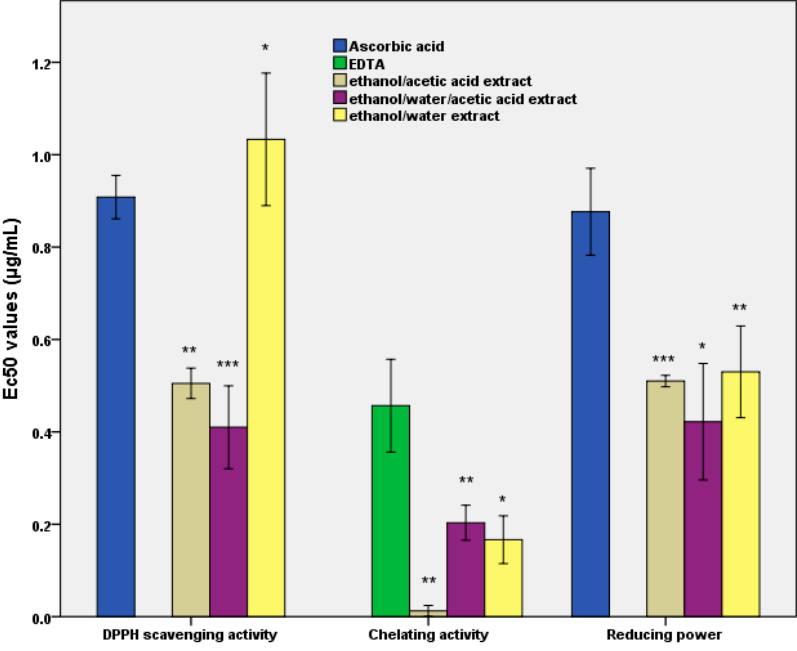
Figure 1. The figure represents the effective concentration (EC50) values for in vitro antioxidant activity as a measure of the impact of curcuma extract after the simulations in the GIS1 system. Different letters mean significant statistical differences ((* = p ≤ 0.05; ** = p ≤ 0.01; *** = p ≤ 0.001), n = 3).